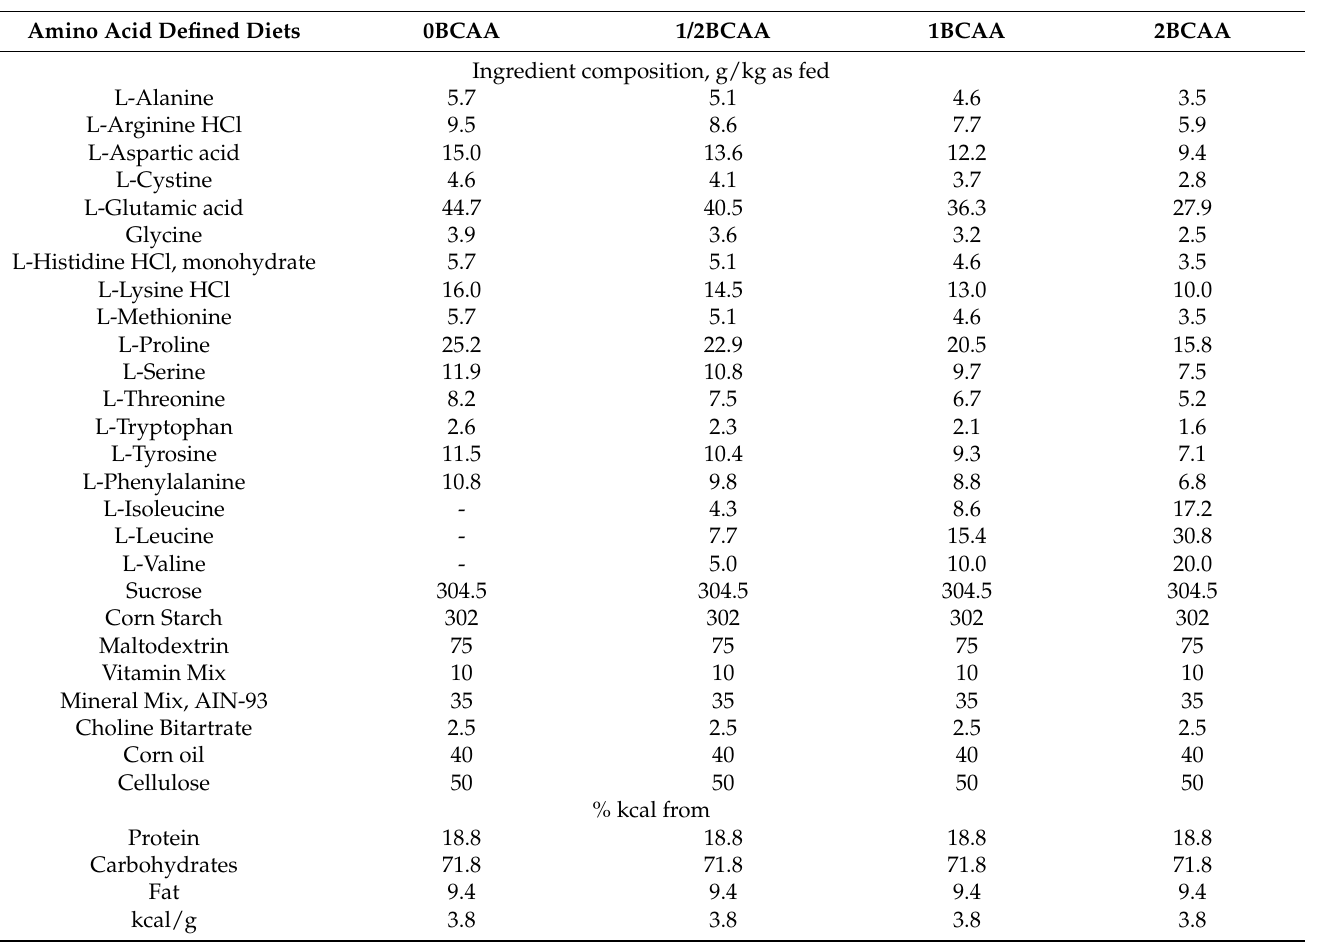
Table 2. The composition of diets. 1BCAA (fully purified amino acid-specified diet), 0BCAA